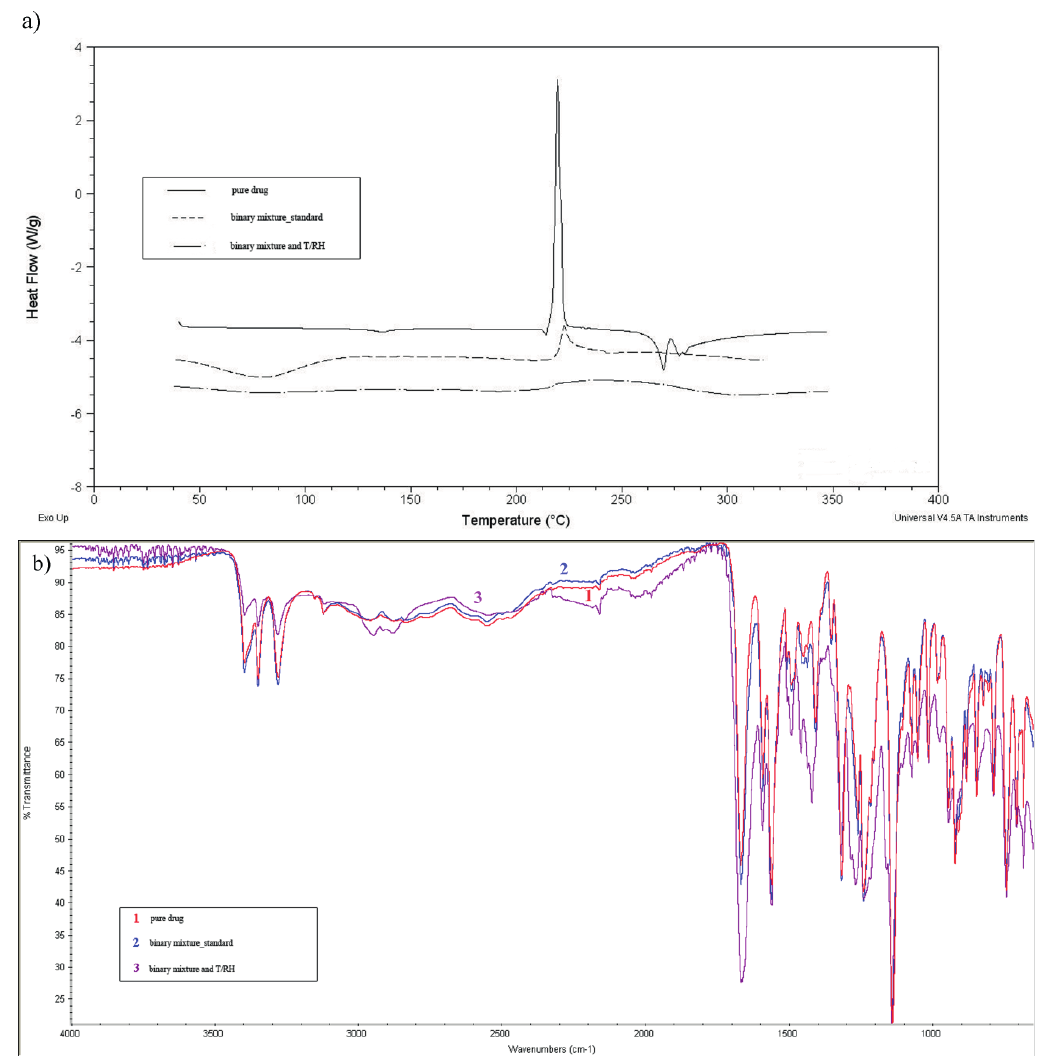
Figure 3 : Furosemide and PVP: DSC scans (a) and FT-IR spectra (b) for the mixture stressed with high temperature/humidity (T/RH) and the untreated mixture (standard) against pure